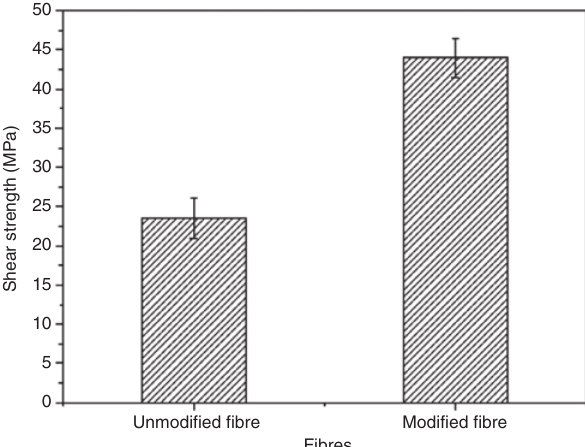
Figure 11: Interfacial shear strength for control flax fiber and FCuNPs grafted fibers to epoxy droplet tested by microbond pull-out test.